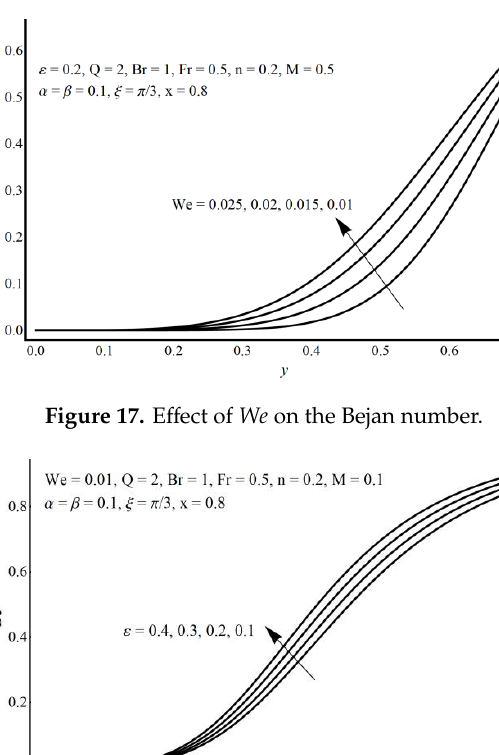
Figure 16. Effect of M on the Bejan number.